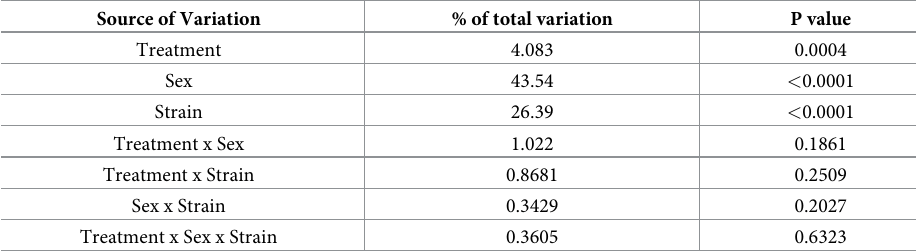
Table 3. Three-way ANOVA analysis of serum levels of 99m